Question: Which visualization type does this figure use?
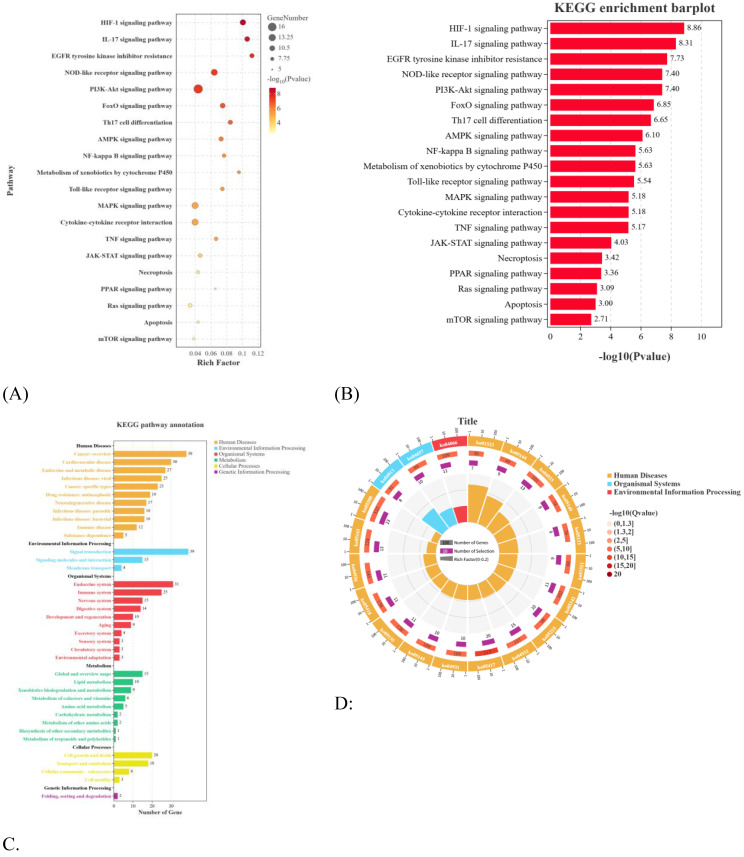
Answer: histogram